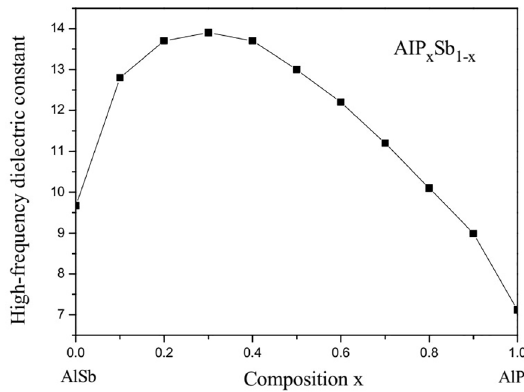
Sb ternary alloys x 1-x